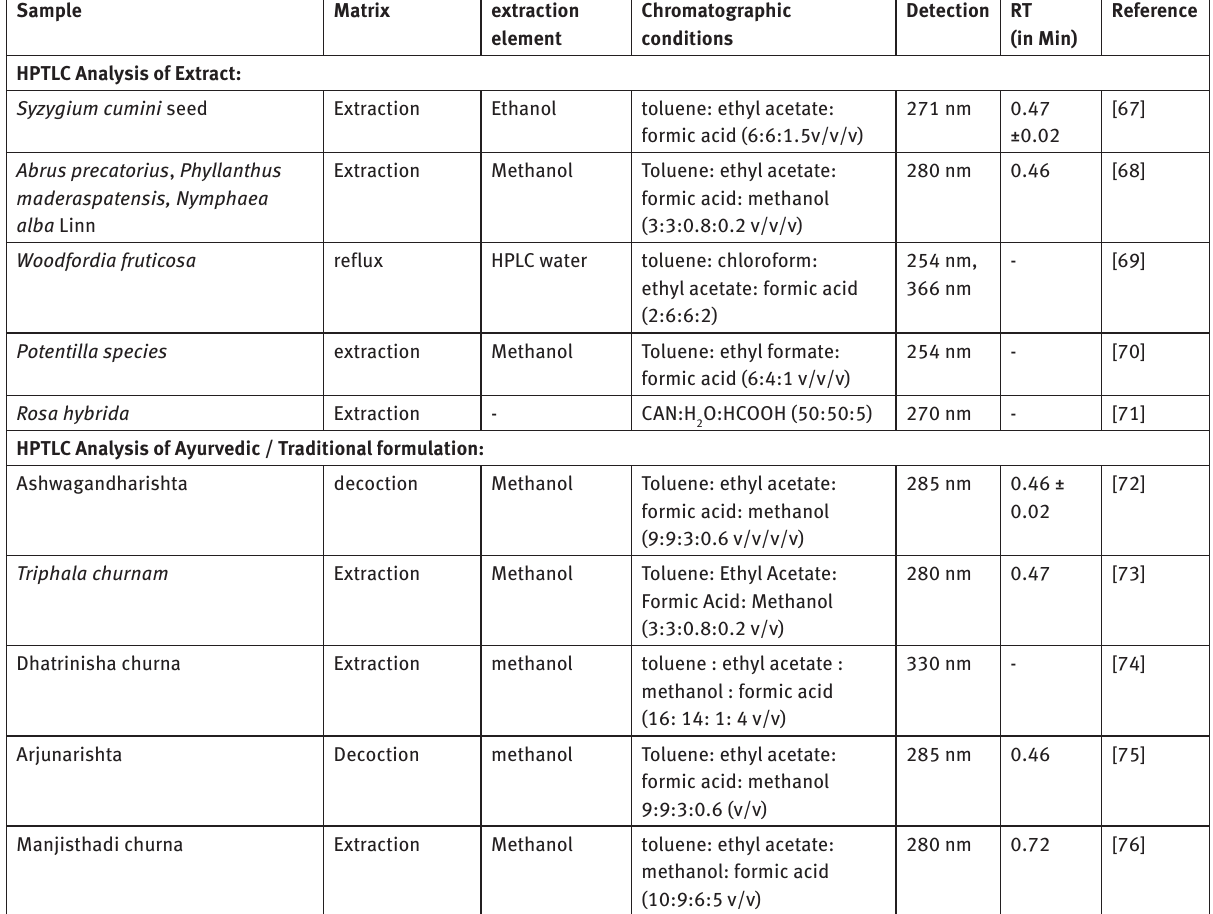
Table 2 Quantitative analysis of ellagic acid by HPTLC methods